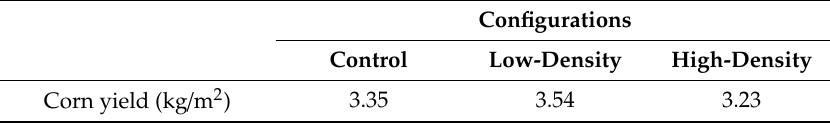
Table 3. Corn yields per square meter for di ff erent configurations.